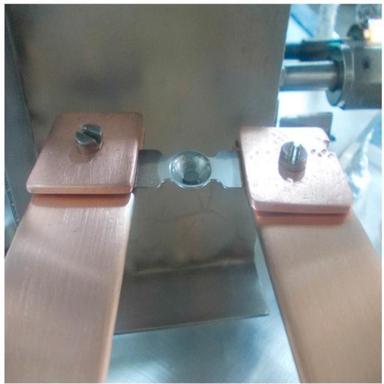
The concave shaped tungsten boat with 61Ni in it.